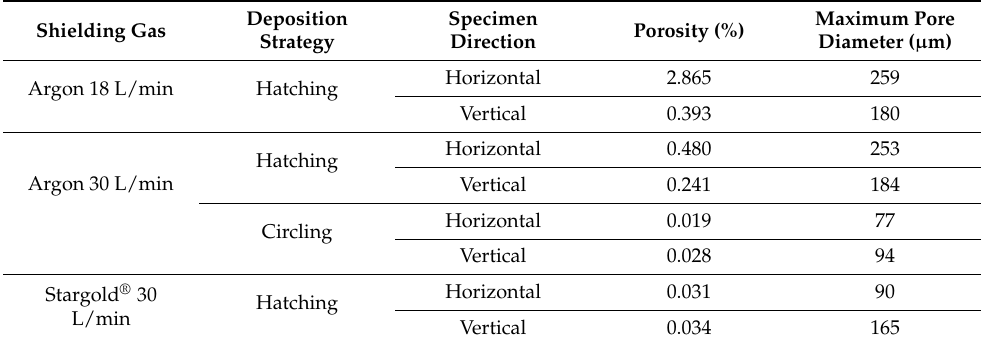
Table 5. Porosity area percentage (%) of WAAM walls manufactured for testing of mechanical properties.